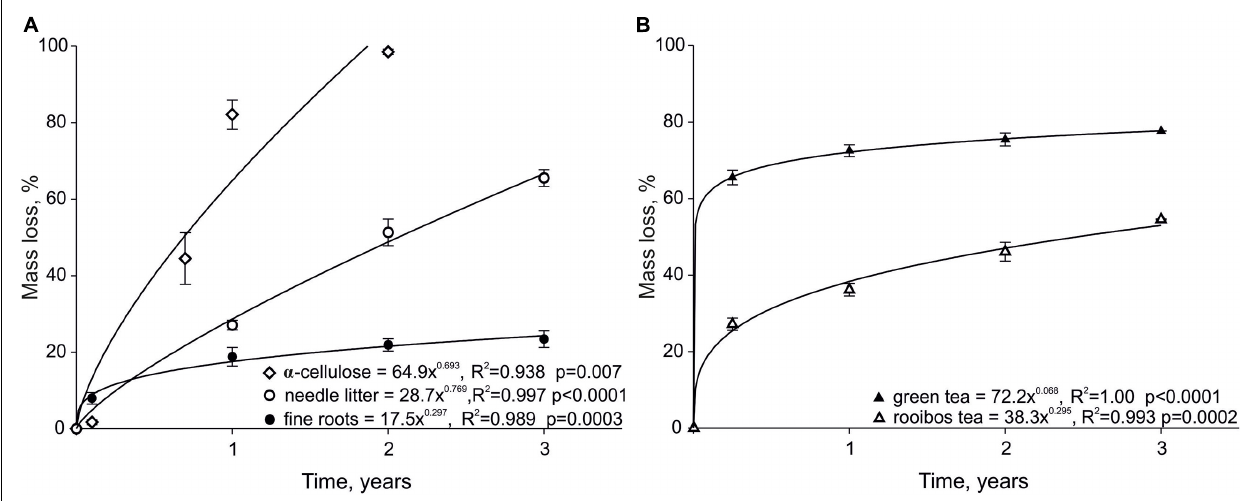
FIGURE 1 | Mass loss (%) of α -cellulose, needle litter, fine roots studied from 2012 to 2015 (A) , green tea and rooibos tea (B) studied from 2016 to 2019. Error bars represent the standard error of means.